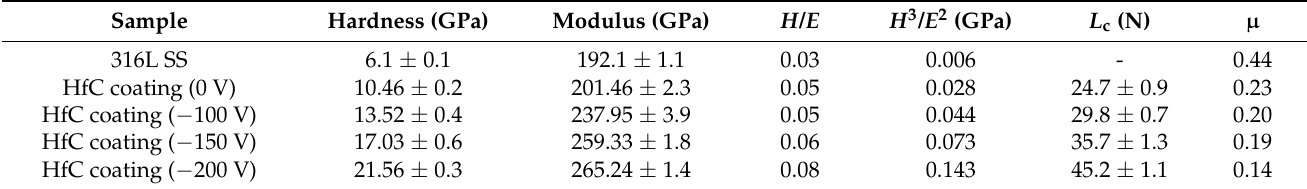
Table 1. Mechanical characteristics, critical load, and friction coefficient of HfC coatings deposited at different bias voltages.